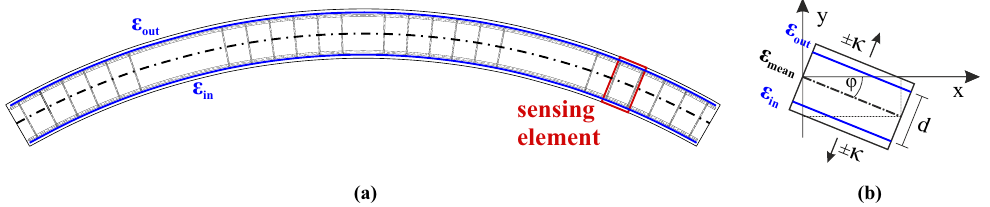
Figure 17. Shape sensing principle: ( a ) Scheme of tunnel segment cross section. ( b ) Detailed view of single sensing element.